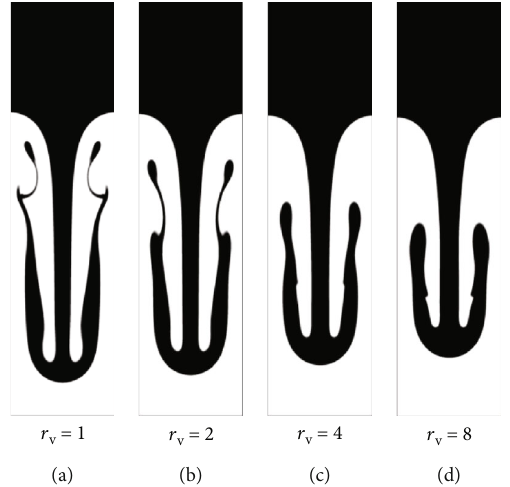
Figure 12: Snapshots of interface shape for di ff erent viscosity ratios ( Re = 256 , At = 0 : 5 , and t ∗ = 5 : 0 ).